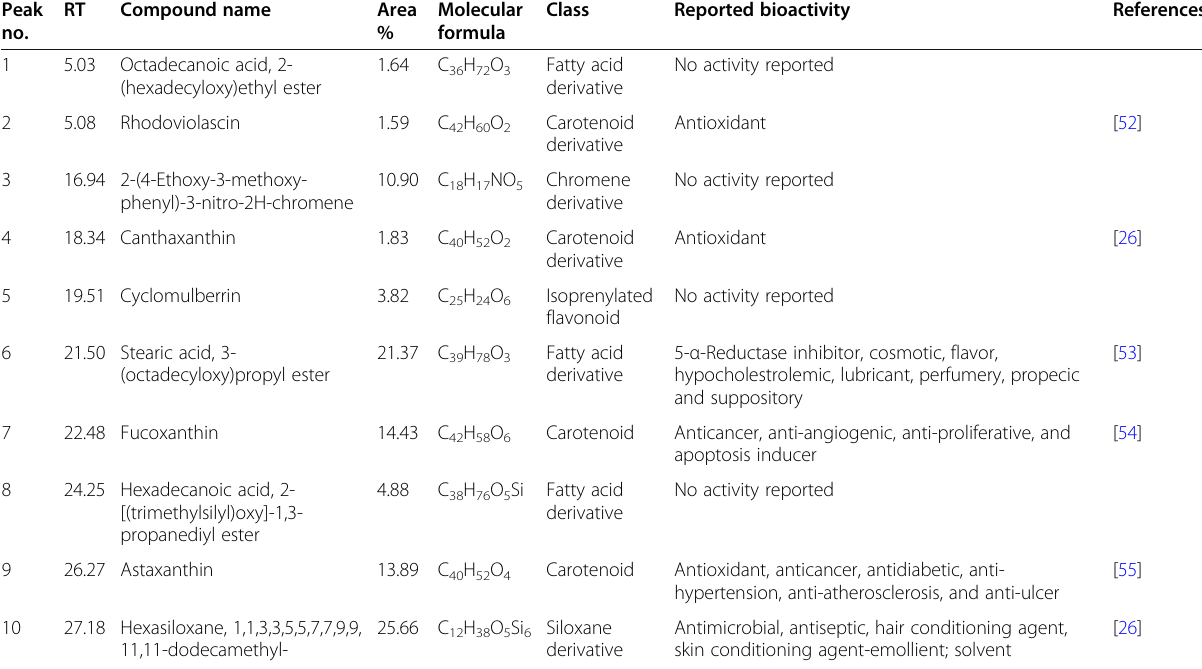
Table 7 Phytochemical components of Suaeda vermiculata ethanolic extract as identified by GC-MS analysis Peak no.